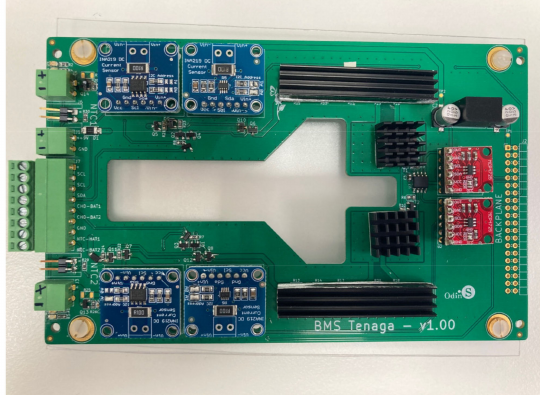
Figure 6. Designed PCB to control the charging and discharging cycles of each cell.